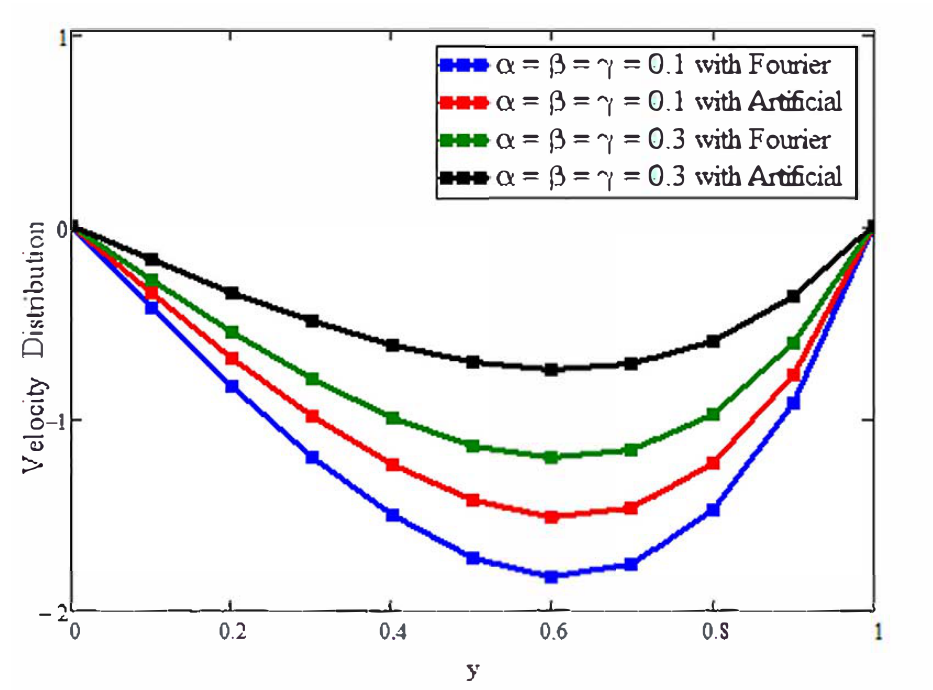
Figure 5. The effects of fractional parameters on the velocity field. Here, a = 0.02, t = 0.2, Pr = 21,